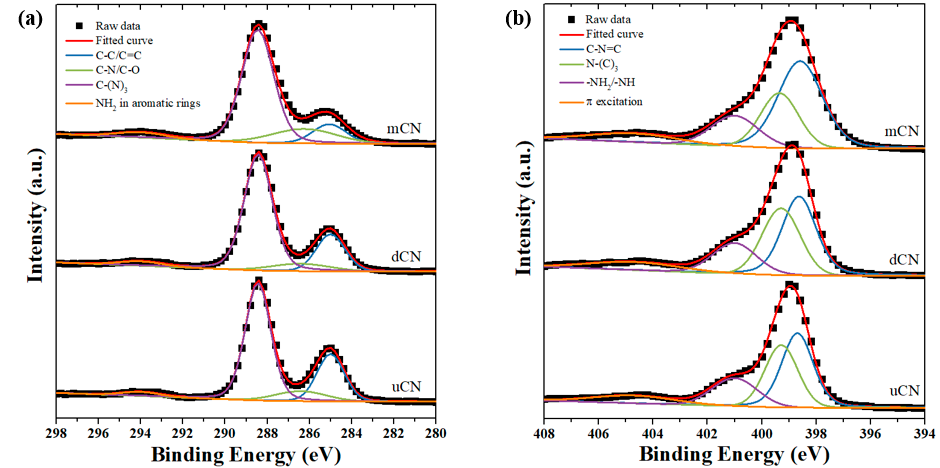
Figure 7. XPS spectra and deconvoluted curves in ( a ) C1s and ( b ) N1s region of gCN samples.